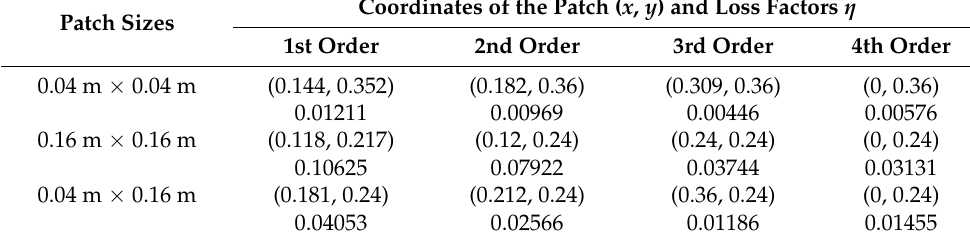
Table 8. Optimization results with different patch sizes for